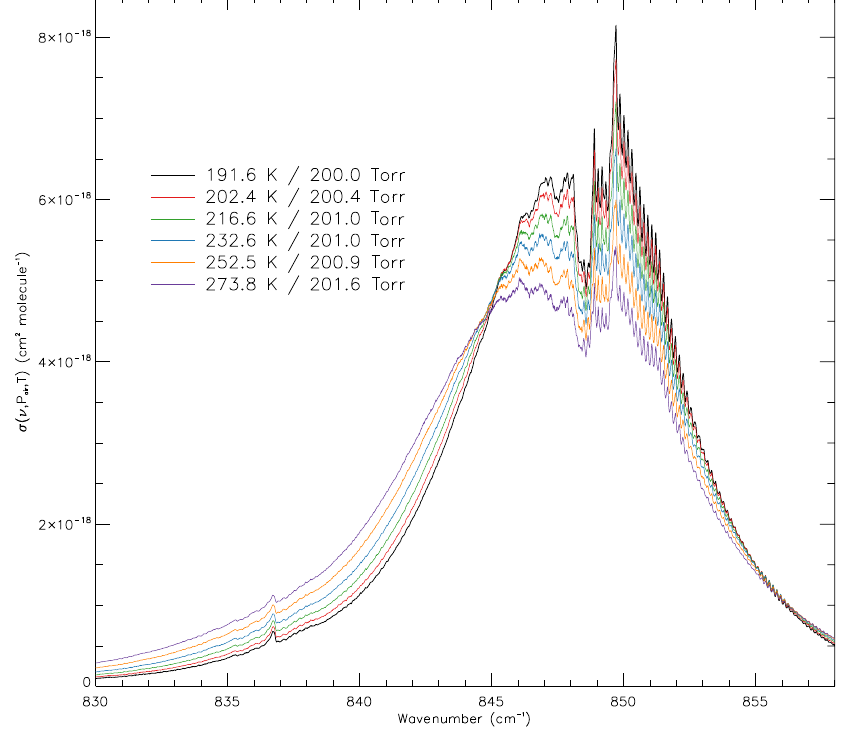
Figure 2. The new absorption cross sections of trichlorofluoromethane/dry synthetic air at a total pressure of ∼ 200 . 0Torr over a range of temperatures (191.6, 202.4, 216.6, 232.6, 252.5, and 273.8K). The observed narrowing of the ν 4 band as the temperature decreases is due to the decline in Boltzmann populations of the upper rovibrational levels of the ground